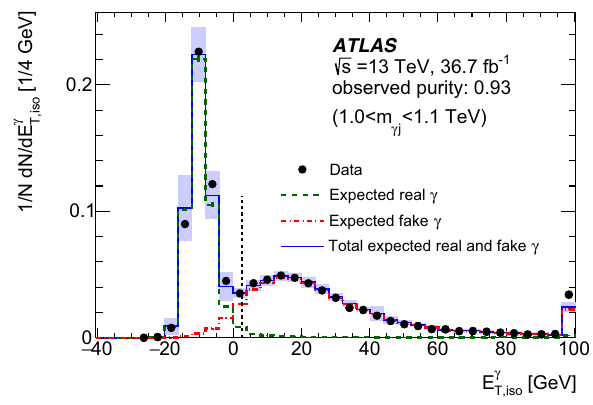
γ = E − 0 . 022 × E γ Fig. 2 Distribution of E for the photon T,iso T,iso T candidates in events with 1 . 0 < m γ j < 1 . 1 TeV, and the comparison with the result of the template fit. Real- and fake-photon components determined by the fit are shown by the green dashed and red dot-dashed histograms, respectively, and the sum of the two components is shown as the solid blue histogram. The blue band shows the systematic uncer- tainties in the real- plus fake-photon template. The last bin of the distri- butionincludesoverflowevents.Theverticaldashedlinecorrespondsto the isolation requirement used in the analysis. The photon purity deter- mined from the fit for the selected sample in the 1 . 0 < m γ j < 1 . 1 TeV mass range is 93%